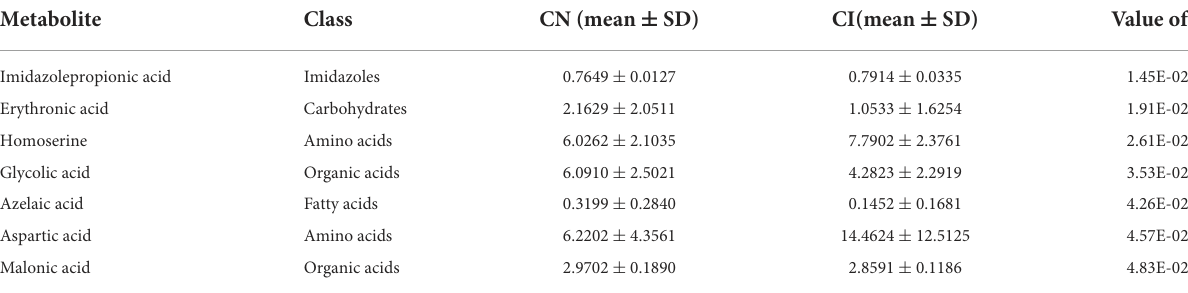
TABLE 2 List of differentially expressed metabolites between CN and CI.